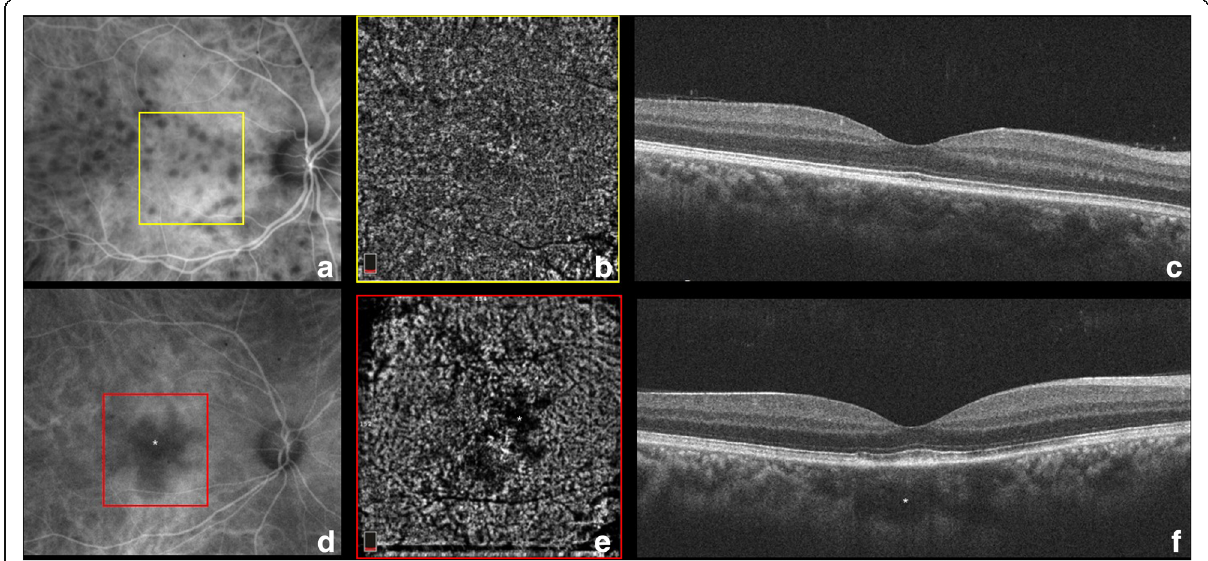
Fig. 5 The upper panels ( a , b , c ) illustrate the right eye of a patient with small sarcoid choroidal granulomas that appear as punctate hypofluorescent lesions with indocyanine green angiography ( a ). These small granulomas are not detected with OCTA at the level of the choriocapillaris ( b ) or by enhanced depth OCT ( c ). This may be because smaller granulomas initially grow in the loose connective stroma of the choroid without alteration of the vascular structure. Their diameter is approximately the size of a choriocapillaris lobule and may not be resolvable with spectral domain OCT. With progressive granuloma growth deeper into the loose choroidal connective tissue, the surrounding vasculature may be shifted and compressed, as illustrated in the bottom panels of the second case. Larger choroidal granulomas tend to occupy the full-thickness of the choroid as noted by the central choroidal hyporeflectance with EDI-OCT ( f ). This lesion can be visualized with OCTA as a central area of choriocapillaris blockage or non-flow ( e ) that colocalizes with ICG hypofluorescence ( d